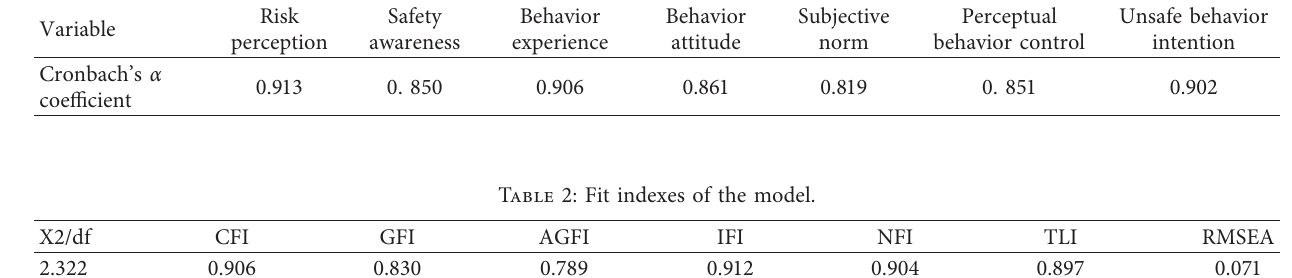
Table 1: Cronbach’s α of each variable.